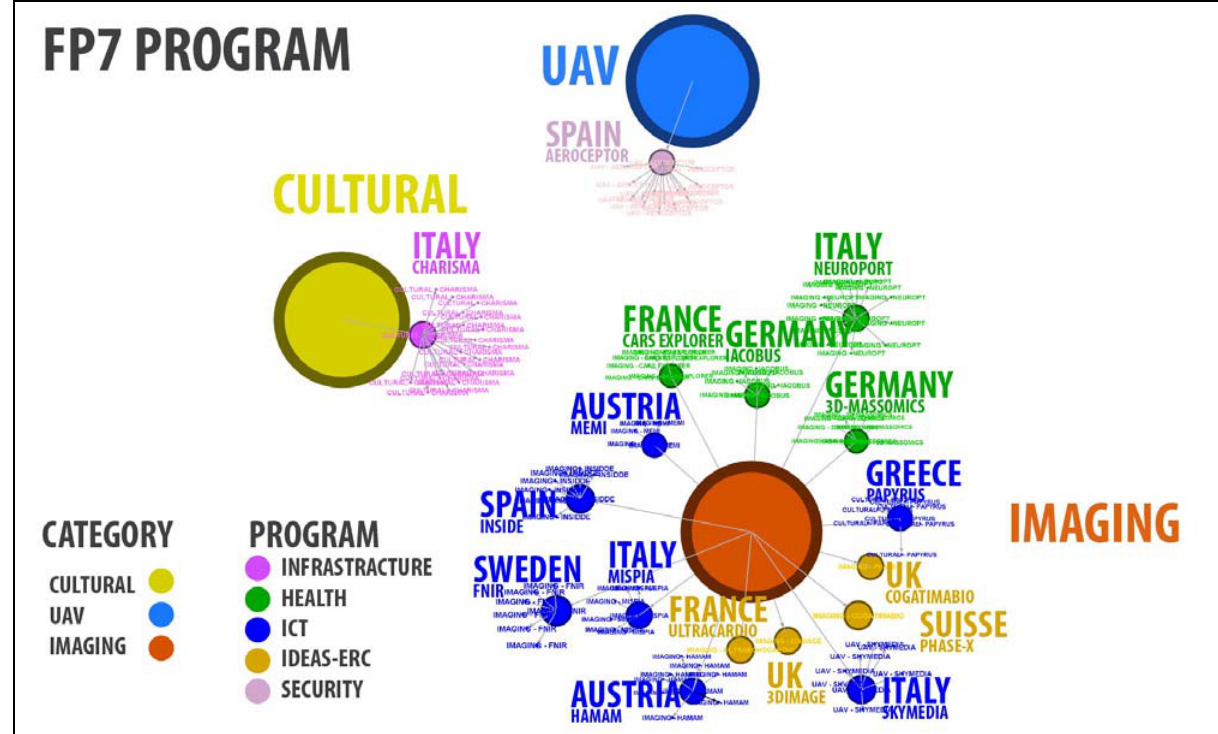
Figure 5. Network analysis of the funded FP7 projects along with the stakeholders and the coordinator